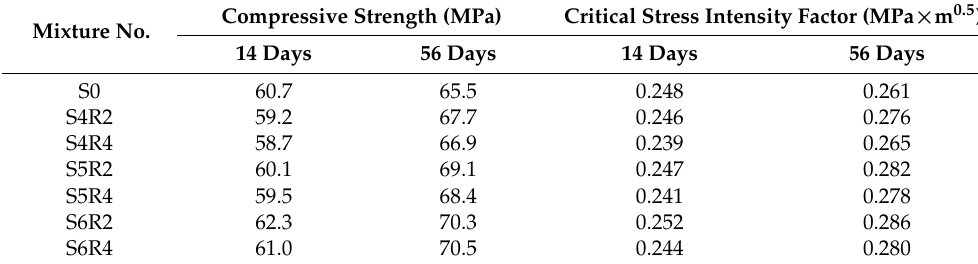
Table 5. Critical stress intensity factor of the concrete.